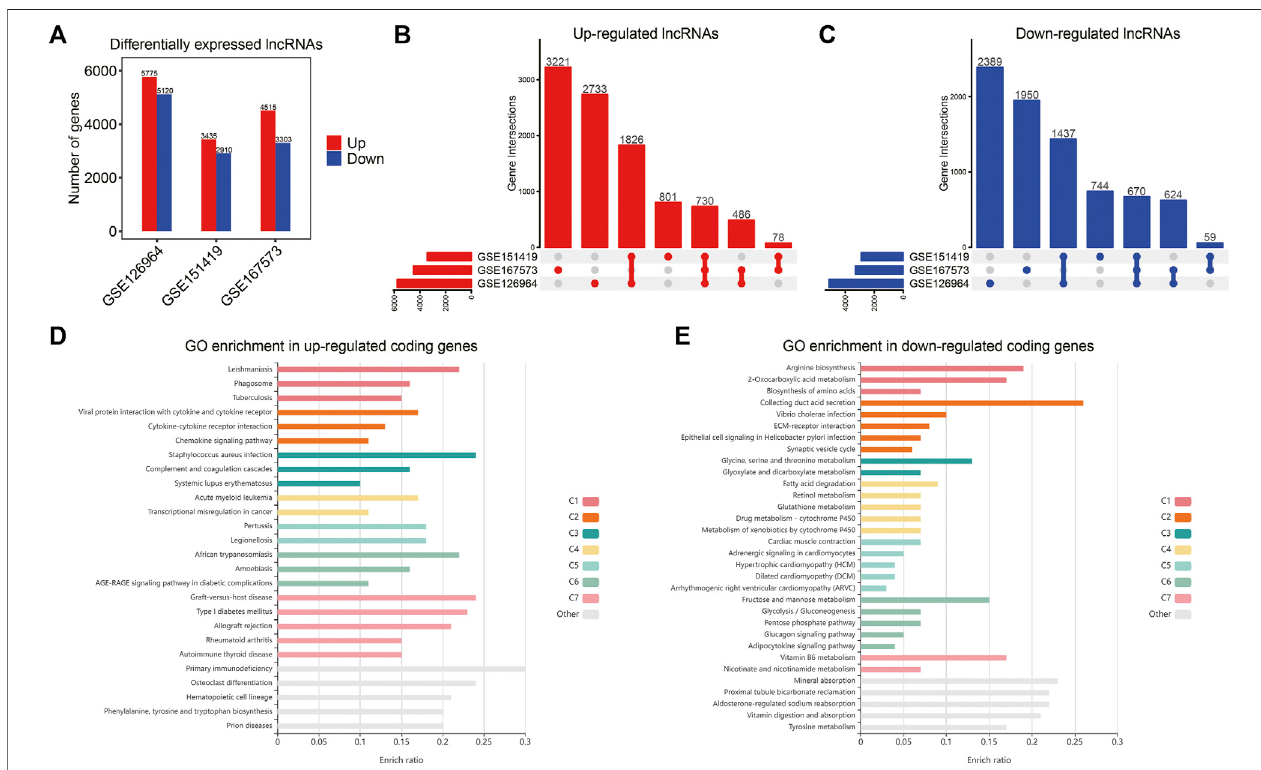
FIGURE3| Identi fi cationofTR-lncRNAs bycomparing tumors withcontrols inRCC. (A) Histogram ofTR-lncRNAs number inthreeGEO datasets. (B) Upset plots of the distribution of upregulated lncRNAs in each dataset. (C) Upset plots of the distribution of downregulated lncRNAs in each dataset. (D) Bar plot showed GO enrichment pathways of upregulated genes. (E) Bar plots showed GO enrichment pathways of downregulated genes.